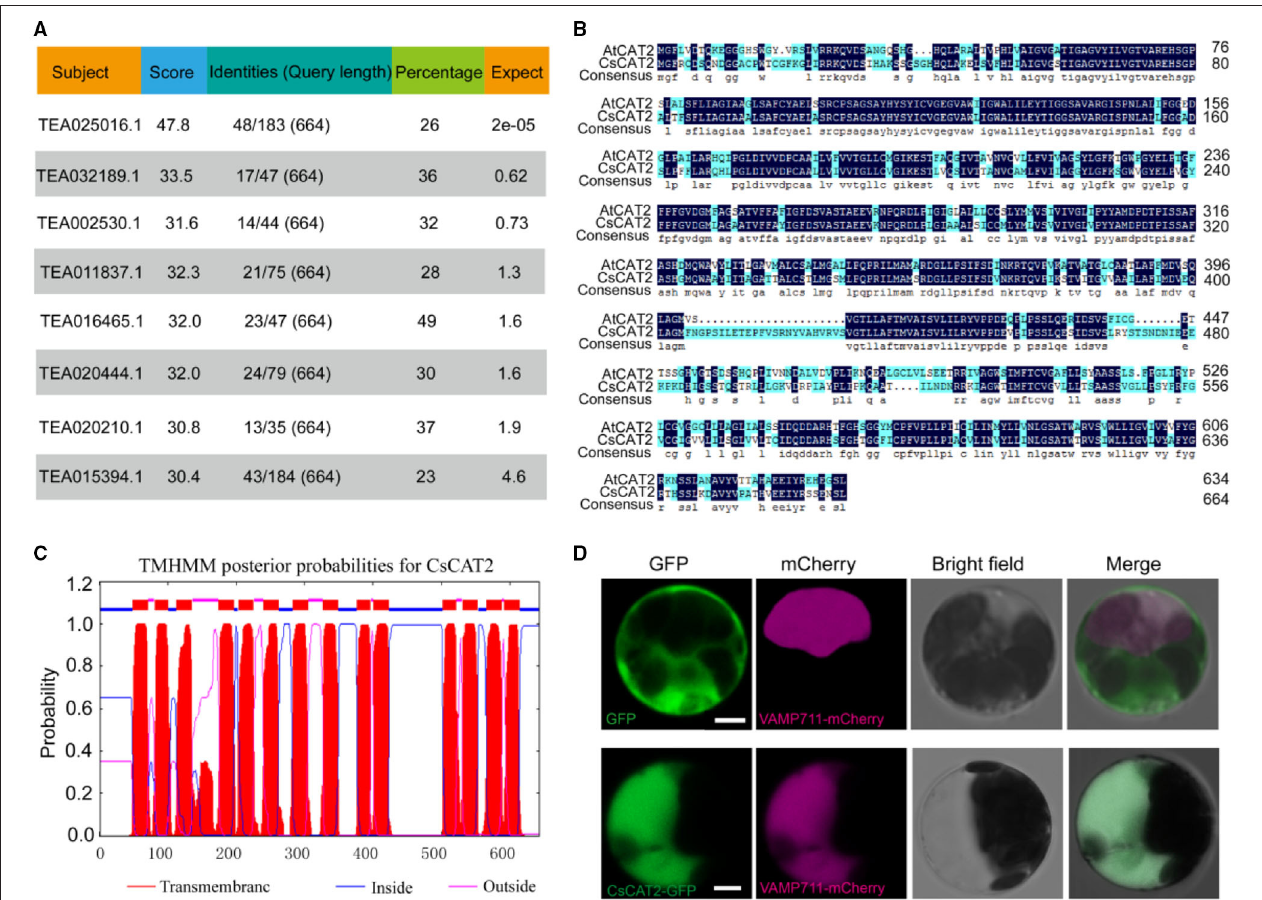
FIGURE 1 | The sequence, transmembrane structure, and subcellular localization of CsCAT2. (A) The similarity of amino acid sequences of proteins in tea plant with the yeast theanine transporter GNP1 (YDR508C). (B) Sequence alignment of CsCAT2 and AtCAT2. (C) CsCAT2 transmembrane domain prediction. (D) Subcellular localization of CsCAT2. PK7WGF2.0-GFP and CsCAT2-GFP fusion proteins were expressed in Arabidopsis protoplasts. Bar = 5 µ m.